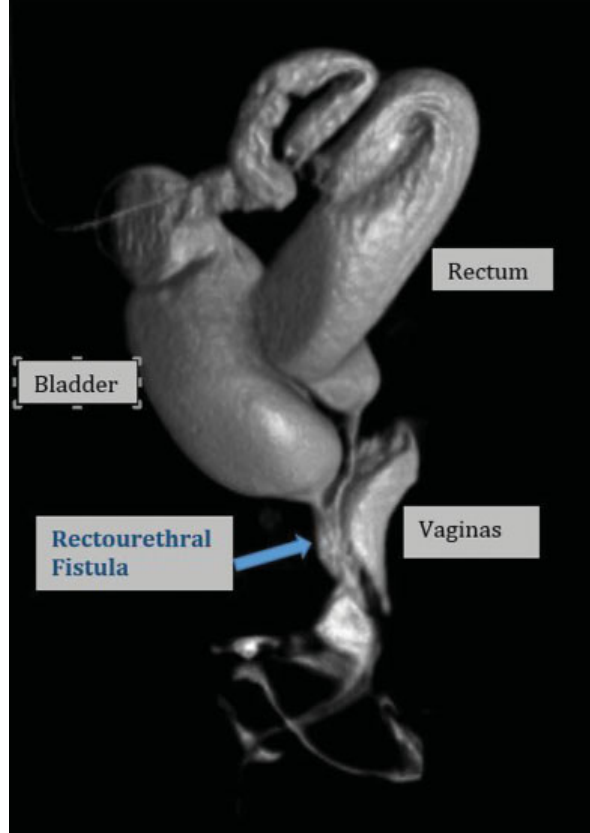
Fig. 2 Rectourethral fi stula,normalvaginaasshownon3Dcontraststudy.